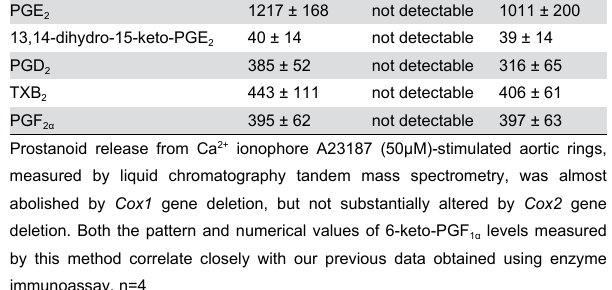
Figure 1. 6-keto-PGF measurement